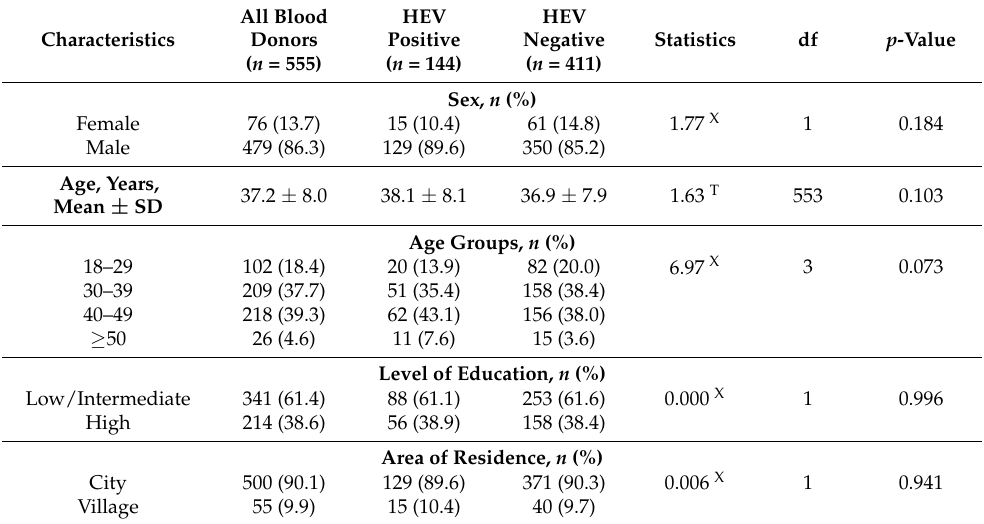
Table 1. Seroprevalence of hepatitis E virus (HEV) infection by sex, age, education, and residence in blood donors from